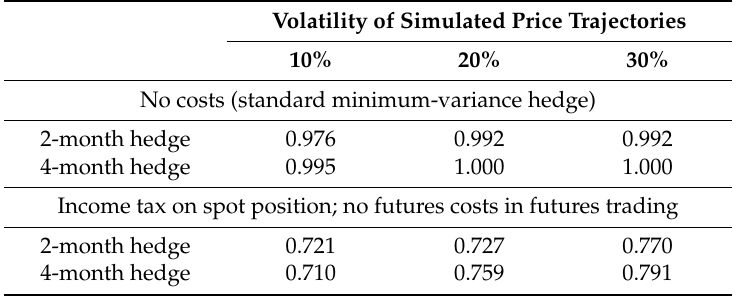
Table 4. Hedge ratios with no costs in futures trading and only income tax on spot